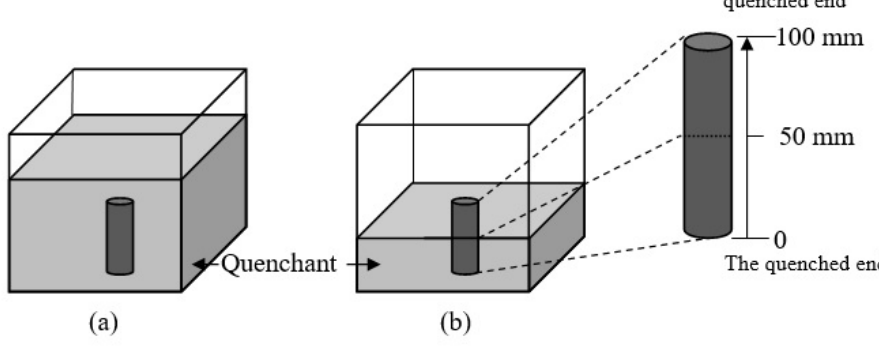
Figure 2. (a) quenching of entire specimen by immersion in quenchant (hardness measurement along transverse section), and (b) quenching half a specimen leaving the other half above quenchant (hardness measurement from quenched end)